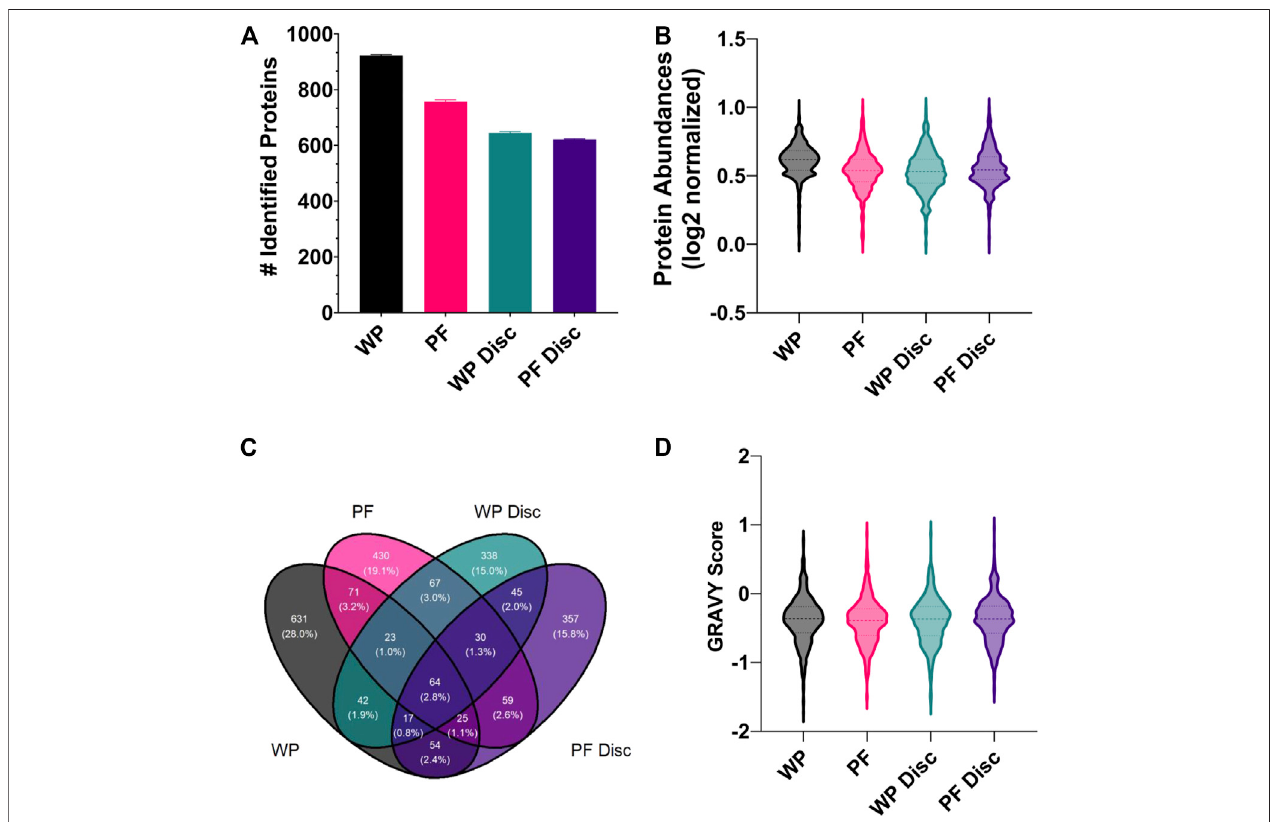
FIGURE 5 | (A) The mean number of rainbow trout proteins identi fi ed in each sample processing method (SPM). The error bars display standard deviation. Abbreviations: WP (wet plasma); PF (Para fi lm). (B) A violin plot illustrating the frequency distribution of average protein abundances within each SPM. All protein abundance data was plotted as mean normalized, log2 transformed. Central dotted line within the violin represent the median and outer lines represent quartiles. (C) A Venn diagram comparing the total number of identi fi ed proteins for each sample processing method (WP, PF, WP Disc, and PF Disc). (D) Violin plot illustrating the frequency distribution of GRAVY scores determined for proteins identi fi ed within each SPM. The WP Disc and the PF Disc represent the protein discs obtained from the modi fi ed Bligh-Dyer extraction. Abbreviation: WP, wet plasma; PF, para fi lm; WP Disc, plasma protein disk); PF Disc, para fi lm protein